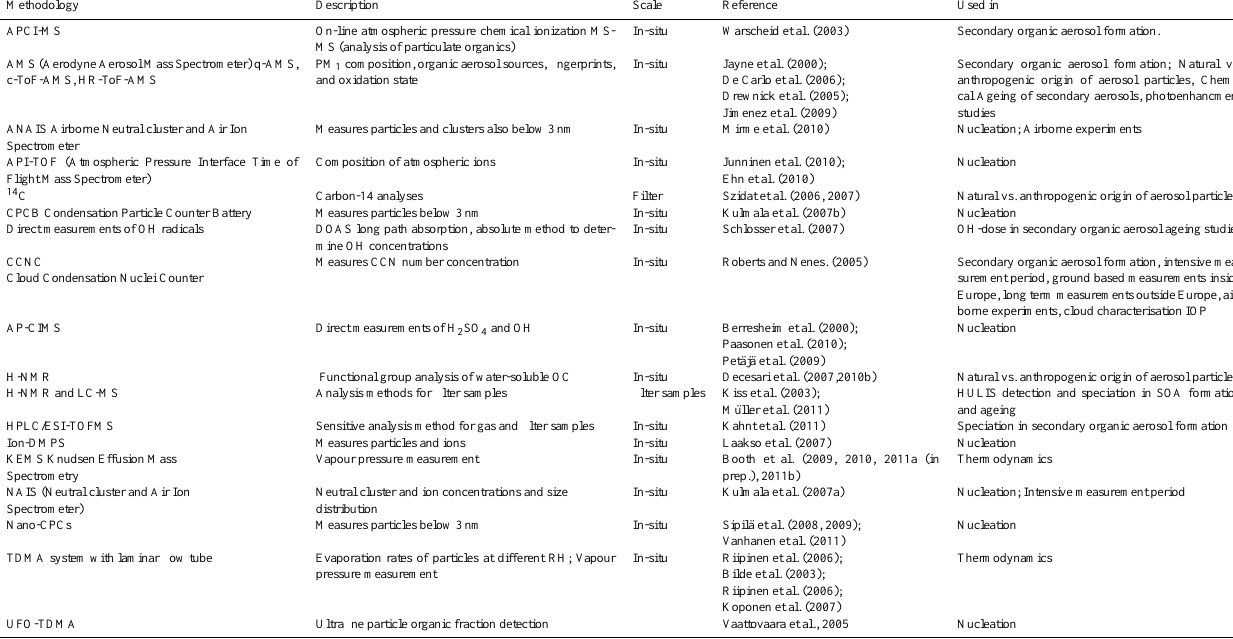
Table A7. Critical instrumentation used in